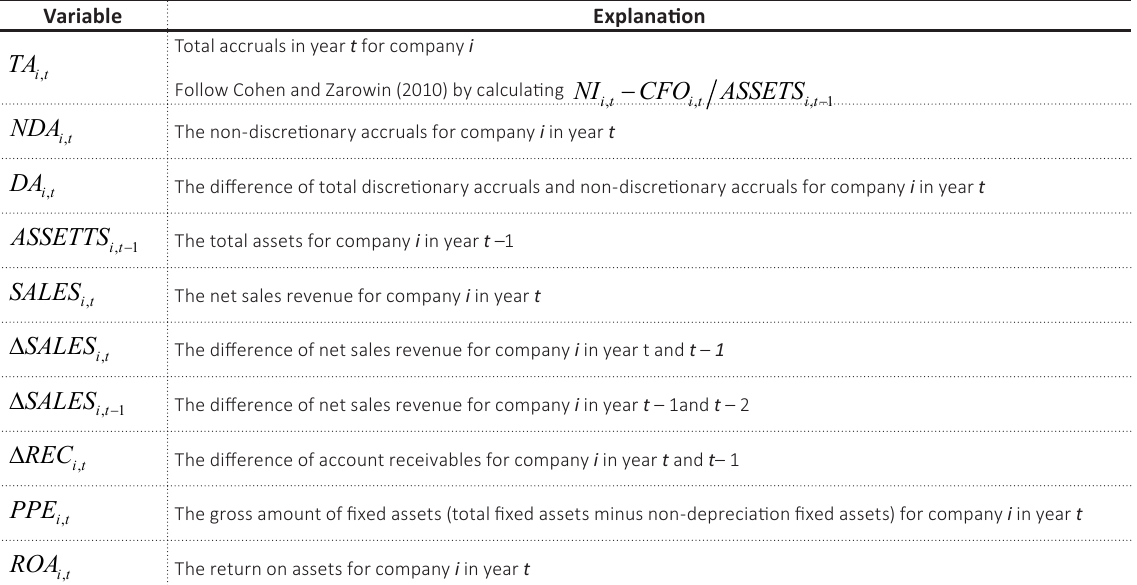
Table A1. Variables related to earnings